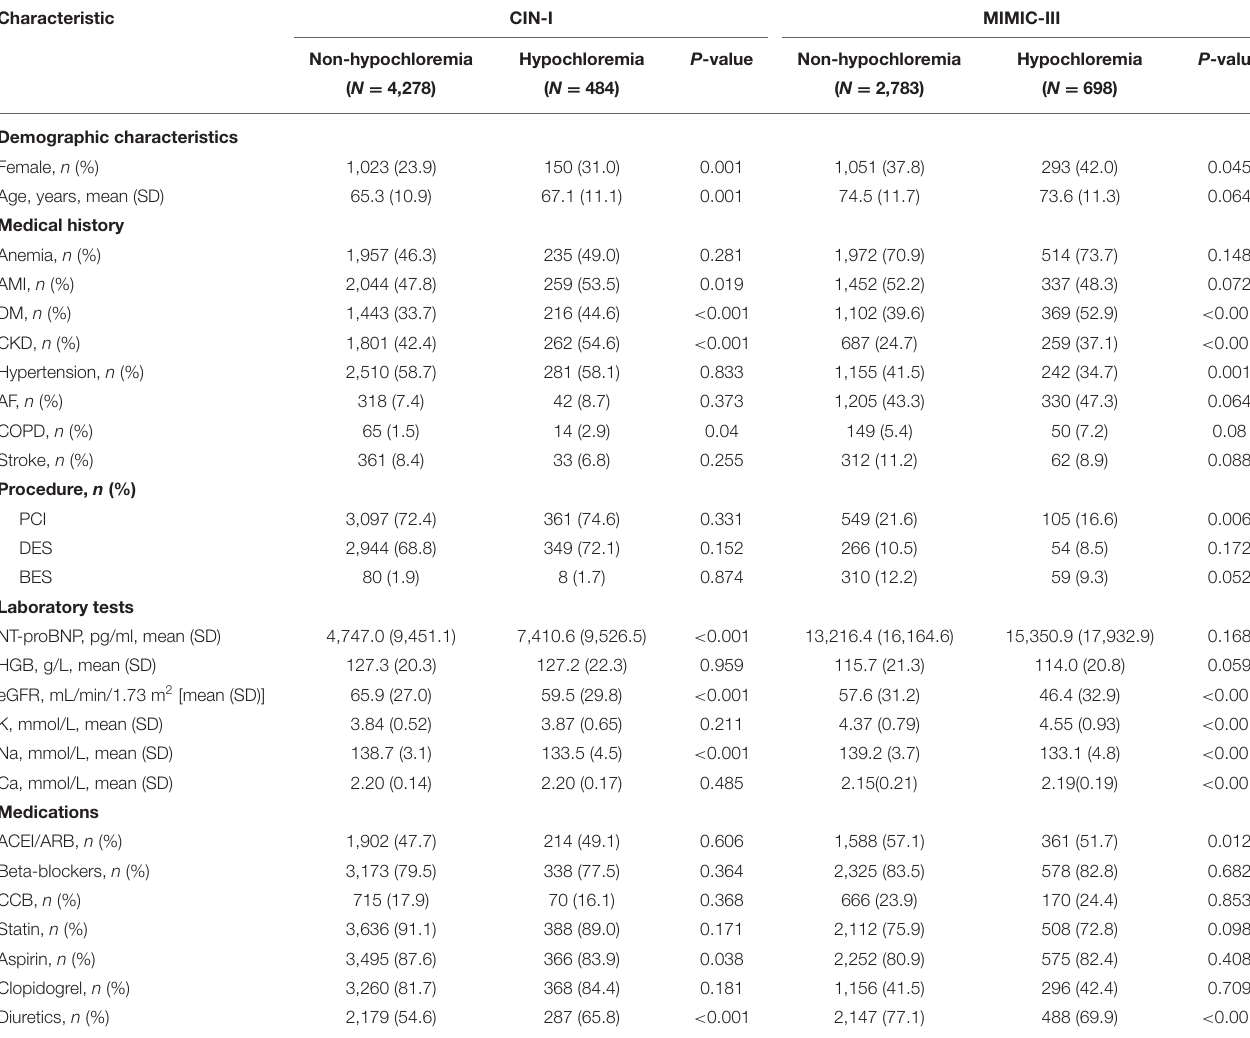
TABLE 2 | Baseline characteristics of the patients with coronary artery disease (CAD) and congestive heart failure (CHF). Characteristic CIN-I MIMIC-III Non-hypochloremia Hypochloremia P -value Non-hypochloremia Hypochloremia P